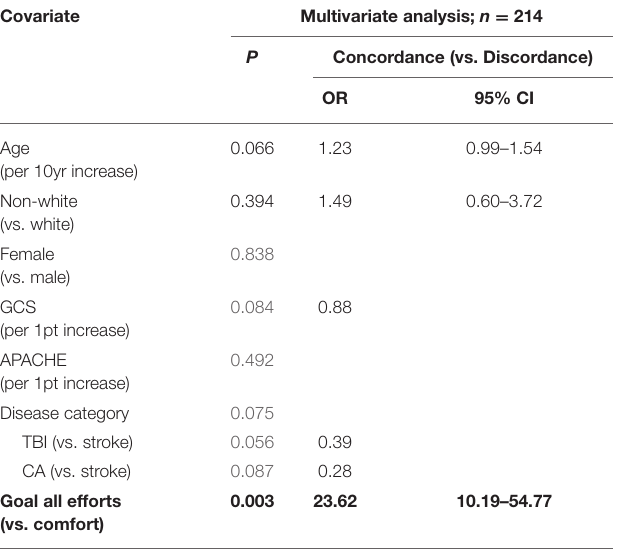
TABLE 3 | Determinants of goal concordance at enrollment ( n = 214). Covariate Multivariate analysis; n = 214